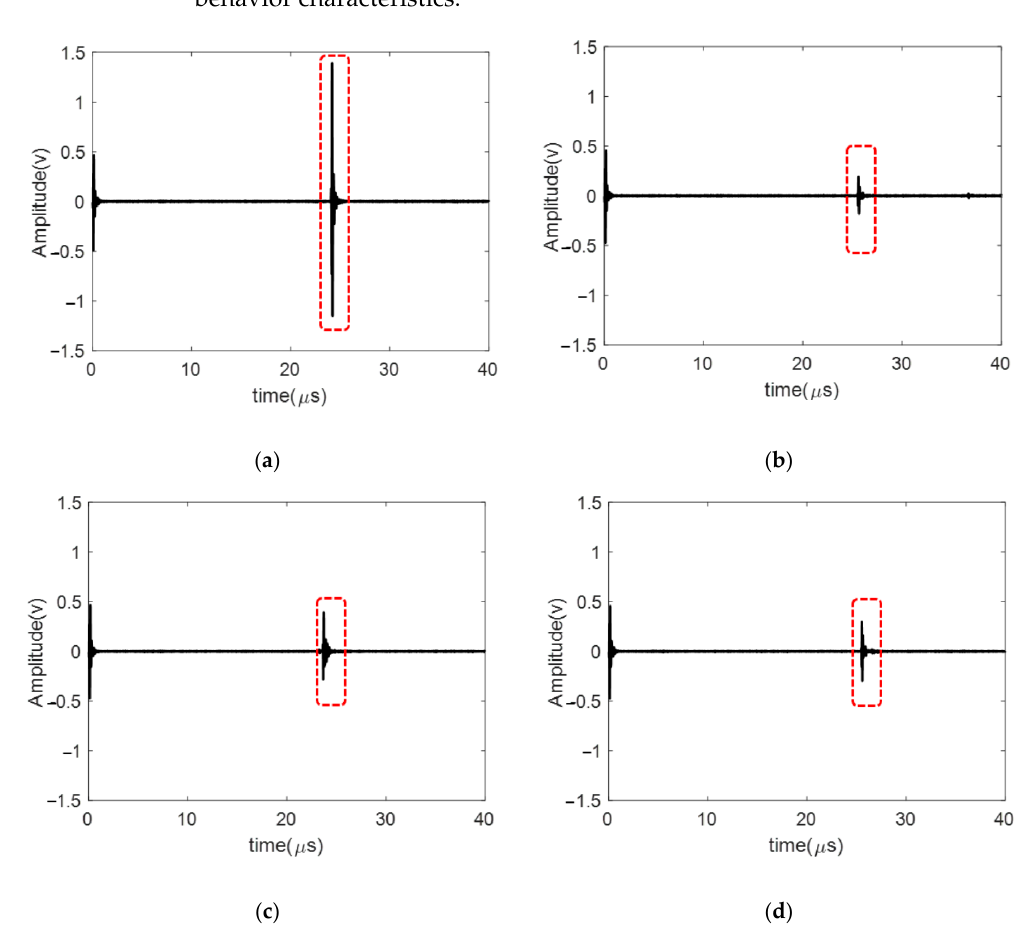
Figure 7. Typical measurements of peak-to-peak amplitude in 700 μ m cracks; ( a ) Non-crack, ( b ) Circum crack, ( c ) Axial crack, and ( d ) Shear crack.